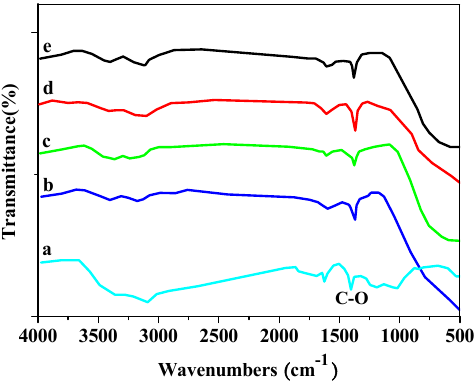
Figure 4. FTIR spectrograms of the different samples (a. GO; b. TiO 2 ; c. N-TiO 2 ; d. TiO 2 /GO; e. N- TiO 2 /GO).